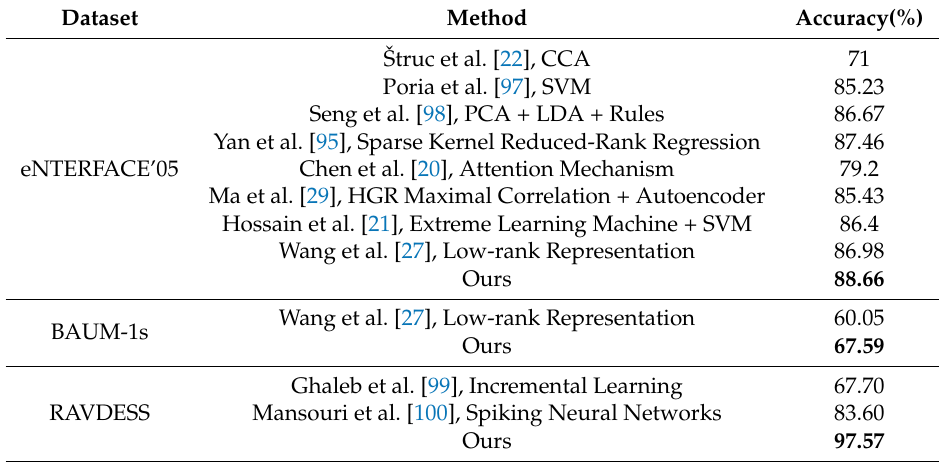
Table 3. The performance comparison of audio-visual emotion recognition with previous works on the eNTERFACE’05, BAUM-1s, and RAVDESS